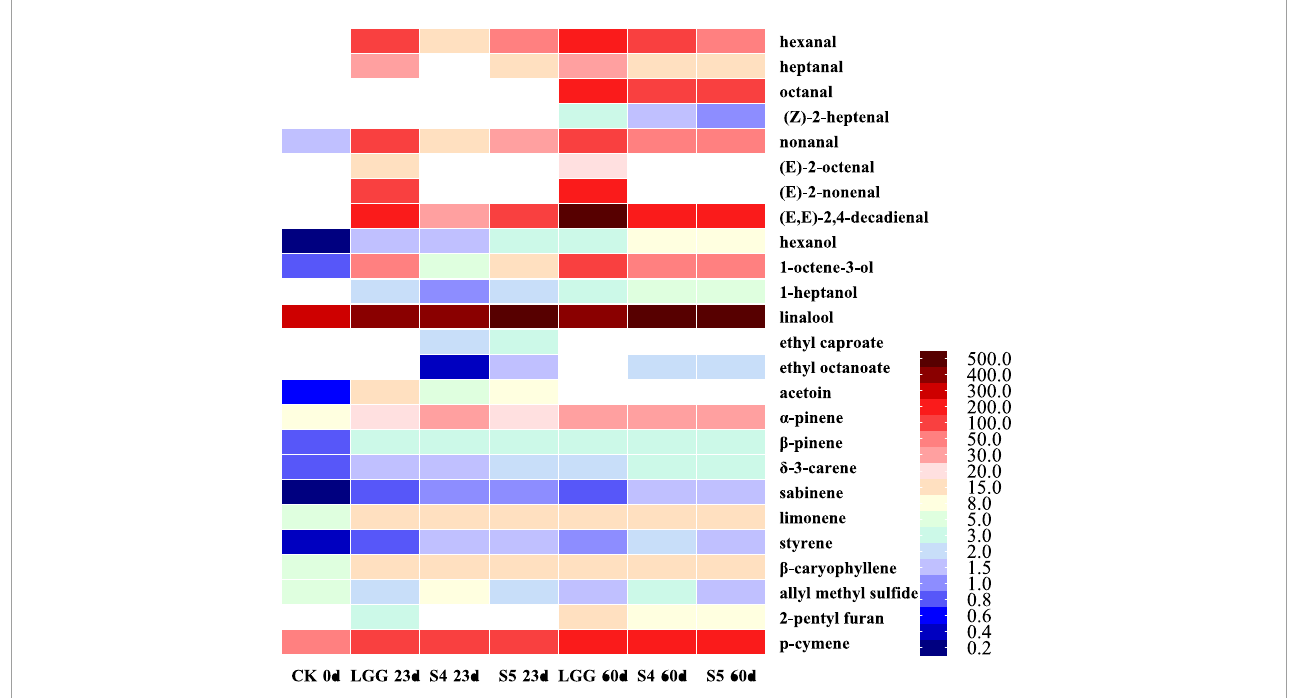
FIGURE9 OAV heat map of key volatile flavor compounds in different fermented sausage samples after storage.